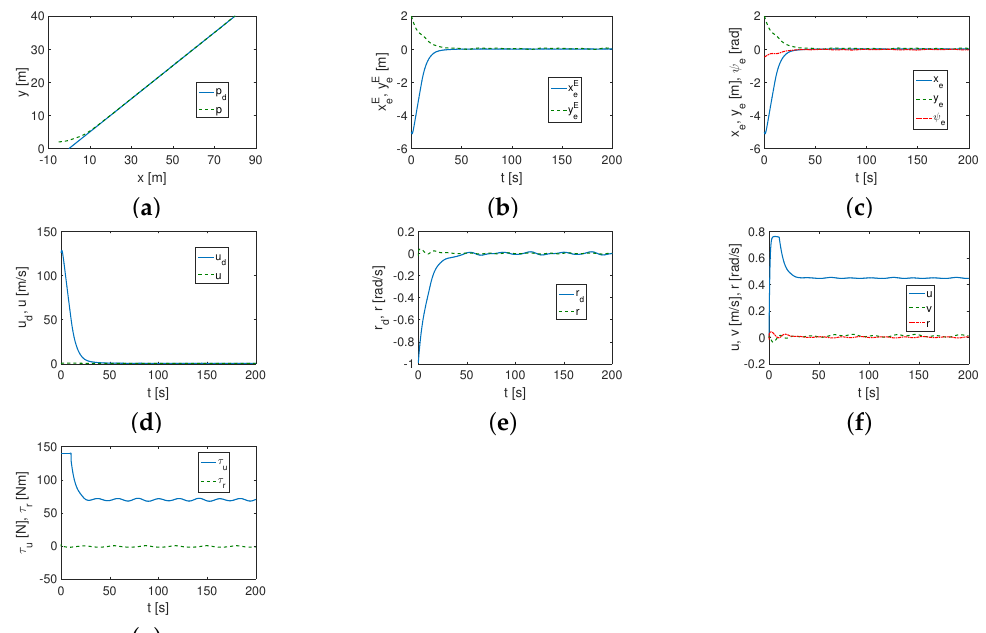
Figure 7. Simulation results for Kambara—IQV controller and linear trajectory (variable distur- bances): ( a ) desired and realized trajectory; ( b ) position errors (E-frame); ( c ) position errors (B-frame) and angular error; ( d ) desired and realized velocity ( u d , u ); ( e ) desired and realized velocity ( r d , r ); ( f ) realized velocities; ( g ) applied force and torque.